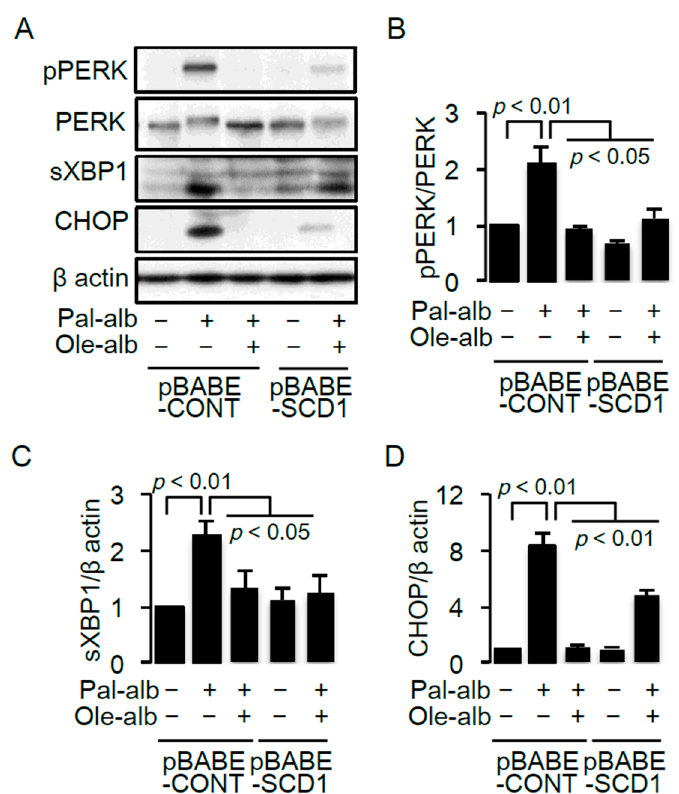
Figure 3. ( A ) Representative immunoblot of pPERK, PERK, sXBP1 and CHOP in cultured proximal tubular cells infected with the control retrovirus (pBABE-CONT) or the retrovirus for SCD1 overexpression (pBABE-SCD1), and treated with/without palmitate or oleate. β -actin was used as a loading control. Quantitative results of the pPERK/PERK ratio ( B ), sXBP1 ( C ) and CHOP ( D ) ( n = 4). Data are shown as mean ± SD. p < 0.05 indicates statistical significance. pPERK, PKR-like ER kinase (PERK) phosphorylated at Thr980; sXBP1, spliced X-box binding protein 1; CHOP, C/EBP homologous protein; SCD, stearoyl-CoA desaturase.